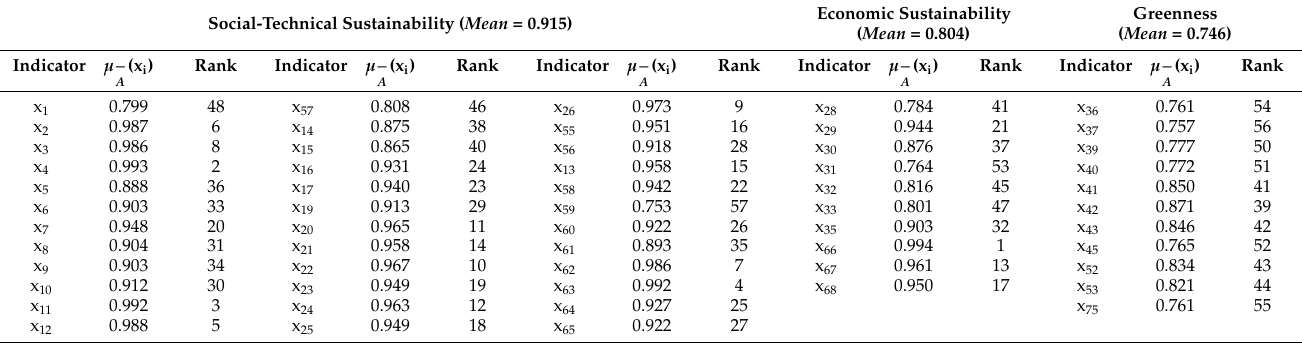
Table 9. Synthesis of sustainability indicators for steel